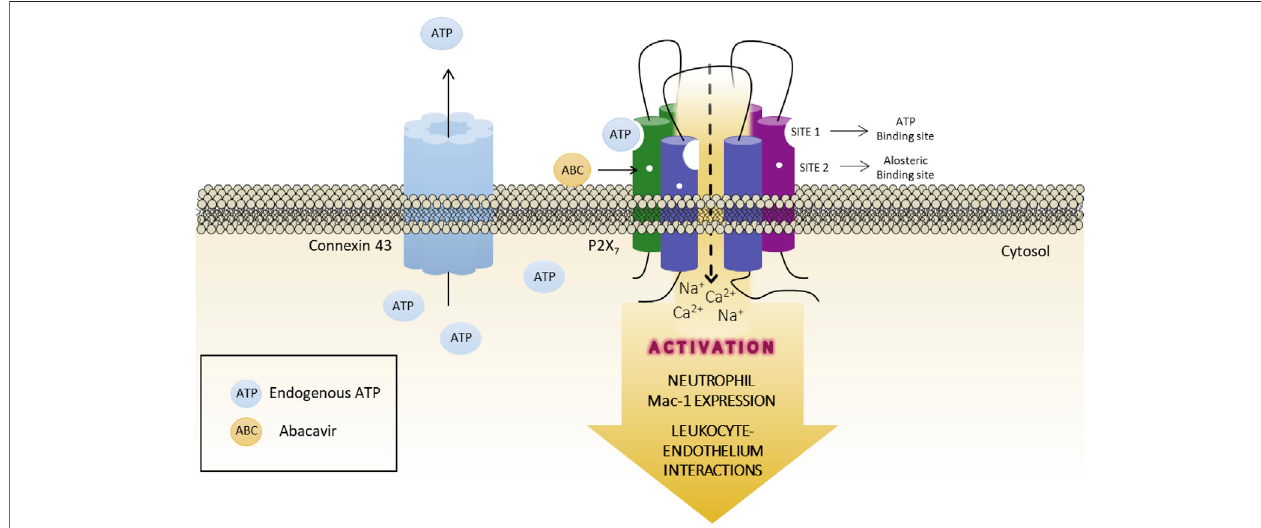
FIGURE 9 | Graphical abstract. Proposed role for ABC acting as an allosteric modulator of the P2X7 receptor. ABC binds to a speci fi c site of the receptor (site 2, allostericbindingsite),butnottoATP-bindingsite(site1),facilitatingtheendogenousATP-P2X7Rbindingtositeoneand,thus,theactivationofthereceptorwithlowand physiological concentrations of ATP. This will lead to an increase in the expression of the adhesion molecule Mac-1 in PMN, which interacts with ICAM-1 on endothelial cells, causing the recruitment of leukocytes seen in the vascular in fl ammatory response induced by ABC. The release of ATP to the extracellular milieu through Connexin43 channels is also implicated in this